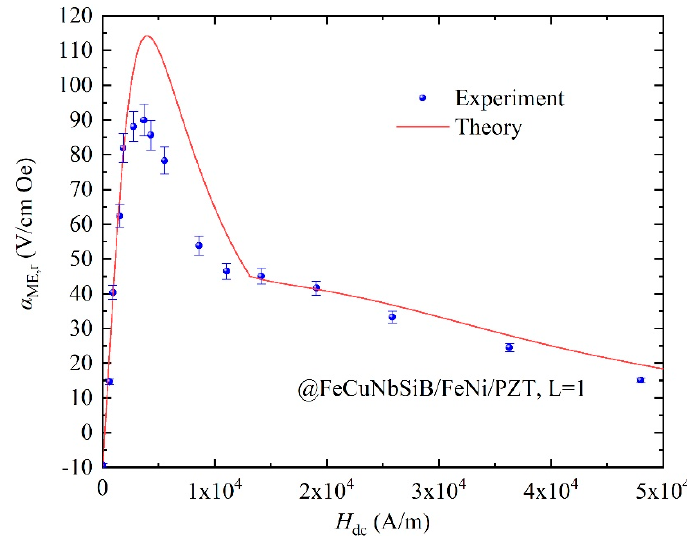
Figure 9. The theoretical and experimental α ME ,r as a function of H dc for FeCuNbSiB/FeNi/PZT.